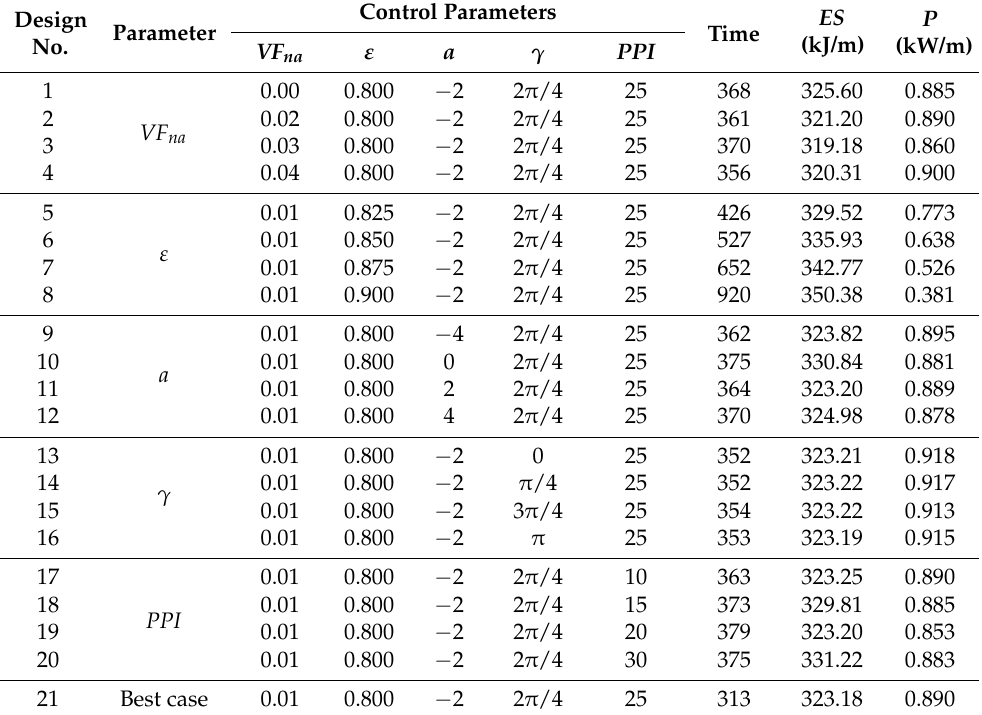
Table 3. The details of 20 test cases for investigation of the impact of design parameters in the melting rate and energy storage when MVF =